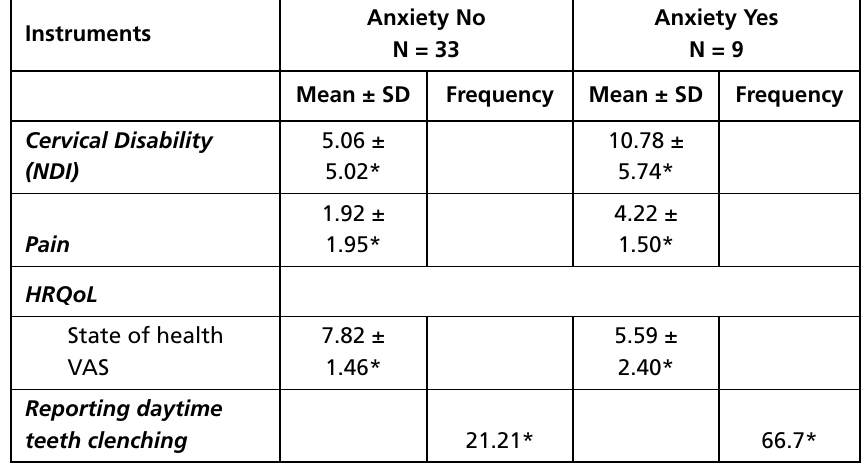
table 6: anxiety/depression as a grouping variable (n =